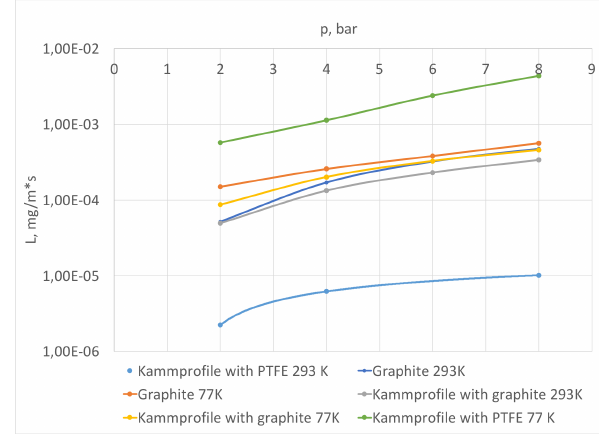
Figure 12: Characteristics of the helium leakage from a flanged joint gasketed with the kammprofile layered of PTFE at ambient and 77 K.